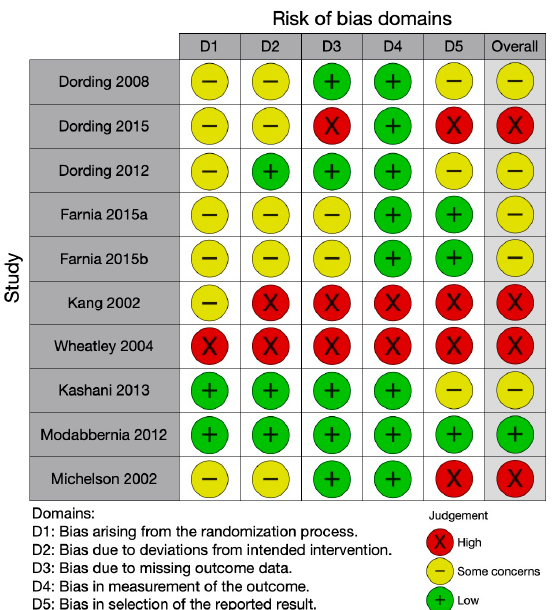
Figure 2. Quality assessment of the included studies